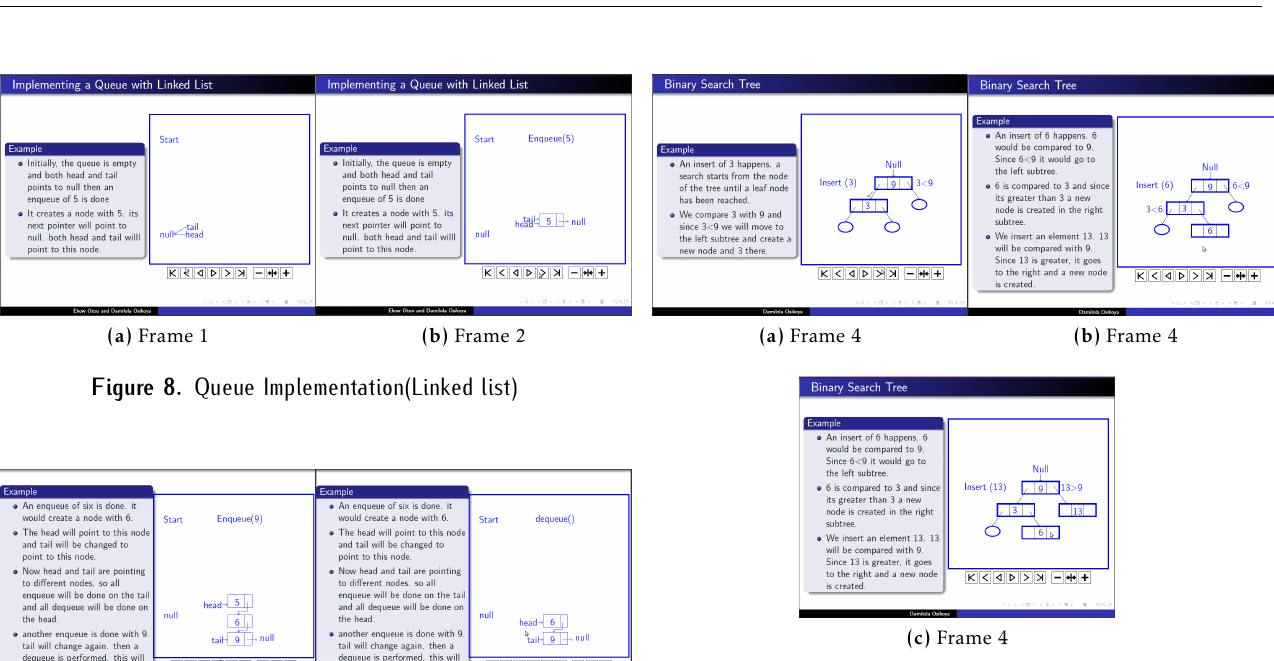
Figure 11. (Insert Operations in a Binary Tree) 5.6. Delete Operations in Trees To perform a Delete() operation in a tree, we either start from the left (Predecessor) or from the right (Sucessor). Using the predecessor, the tree scans the left of the largest element (in this case 6). It replaces node 9 with it and deletes the node which 6 occupies.